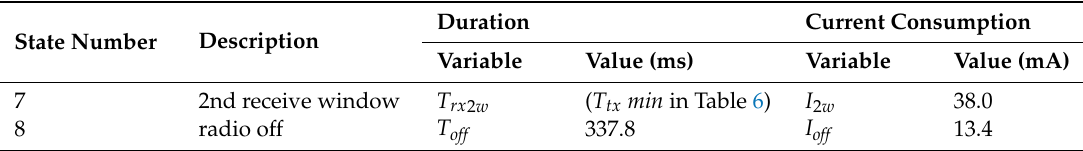
Table 8. States, variables and their values for LoRaWAN acknowledged transmission when the acknowledgment is sent in the second receive